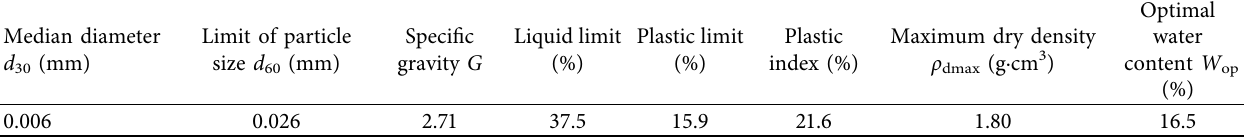
Table 1: Indices of the properties of high plasticity clay.